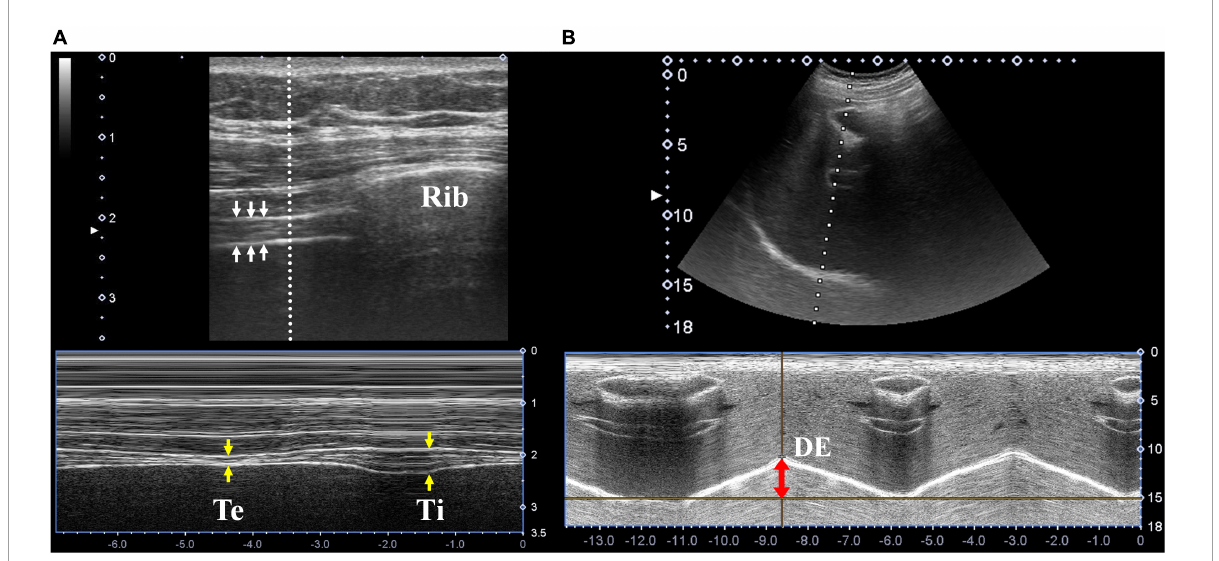
FIGURE1 Diaphragmatic ultrasonography. (A) Ultrasonographic images of the diaphragm (white arrows) in the longitudinal plane were located in the right 7 th intercostal space along the mid-axillary line. The thickness at end expiration (yellow arrows, labeled as “Te”) and end inspiration (labeled as “Ti”) were measured using M-mode ultrasonography. (B) Ultrasonographic images of the diaphragm in the sagittal plane were located in the right subcostal area between the mid-clavicular and anterior axillary lines. Diaphragm excursion was measured using M-mode ultrasonography (red double-head